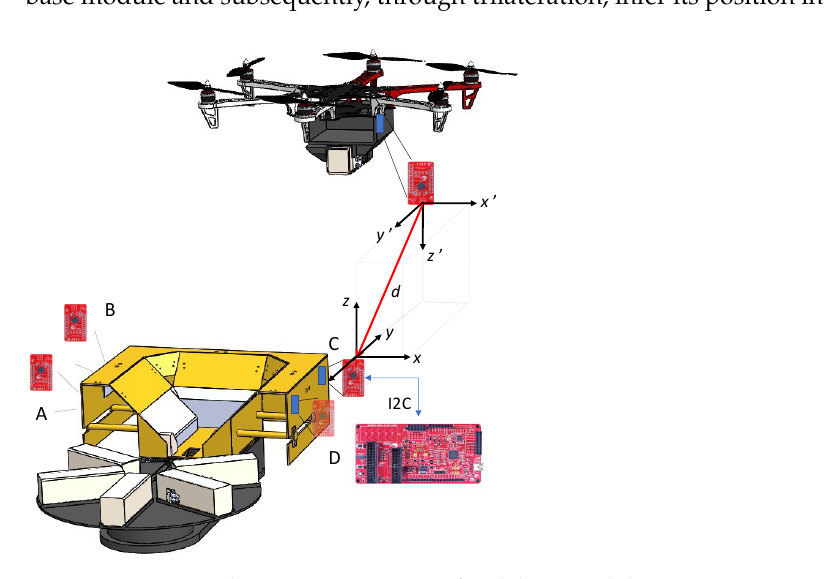
Figure 7. Conceptual RSSI target position of each base